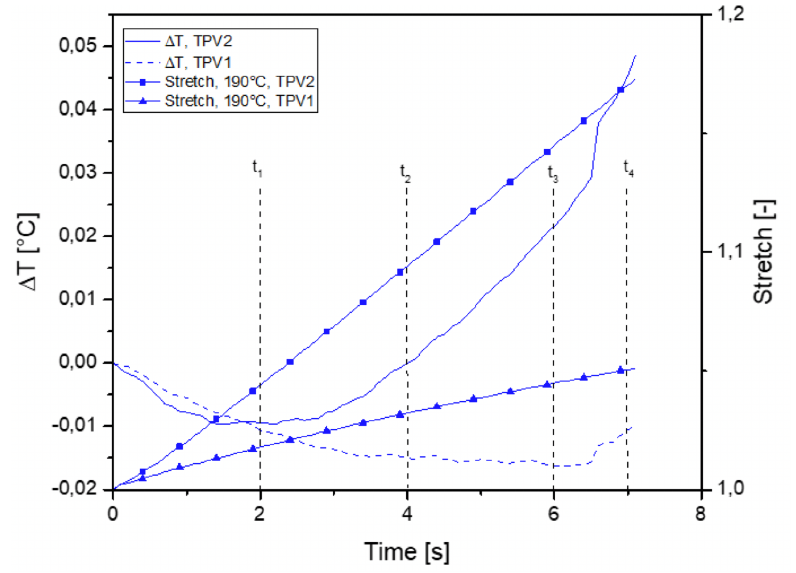
Figure 15. Temperature change with stretch for specimen overmoulded at 190 ◦ C, in the case of monotonic tensile test until rupture.